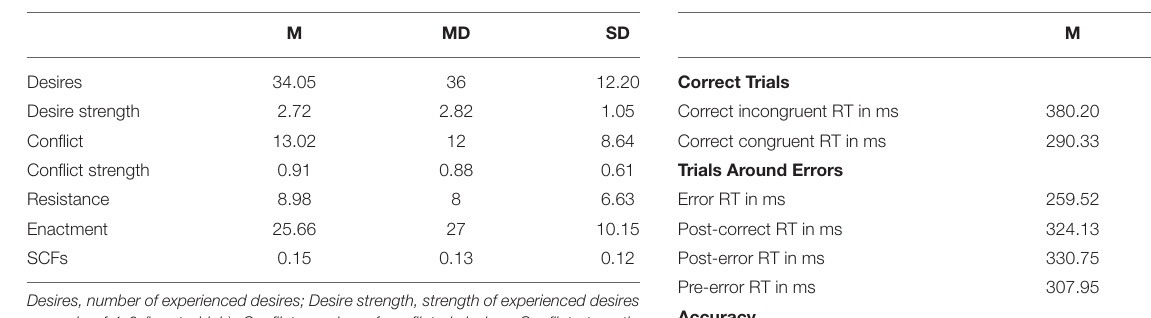
TABLE 1 | Measures (means, medians, and standard deviations) in ecological momentary assessment.